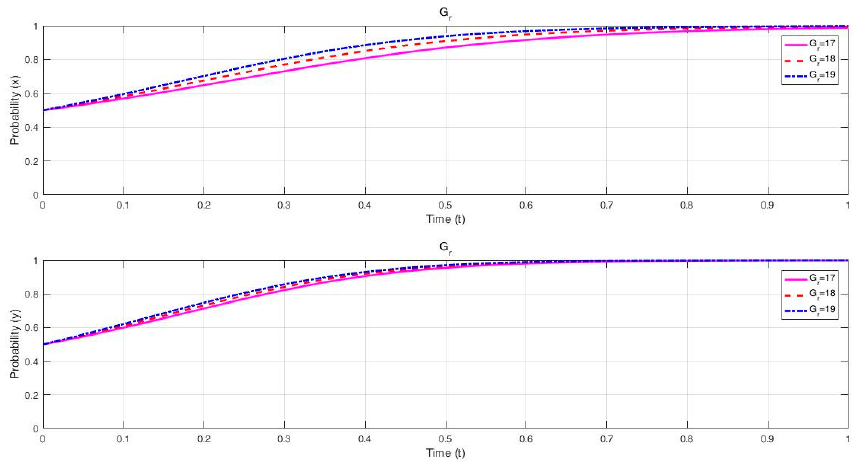
Figure 4. The impact of G r on the game.